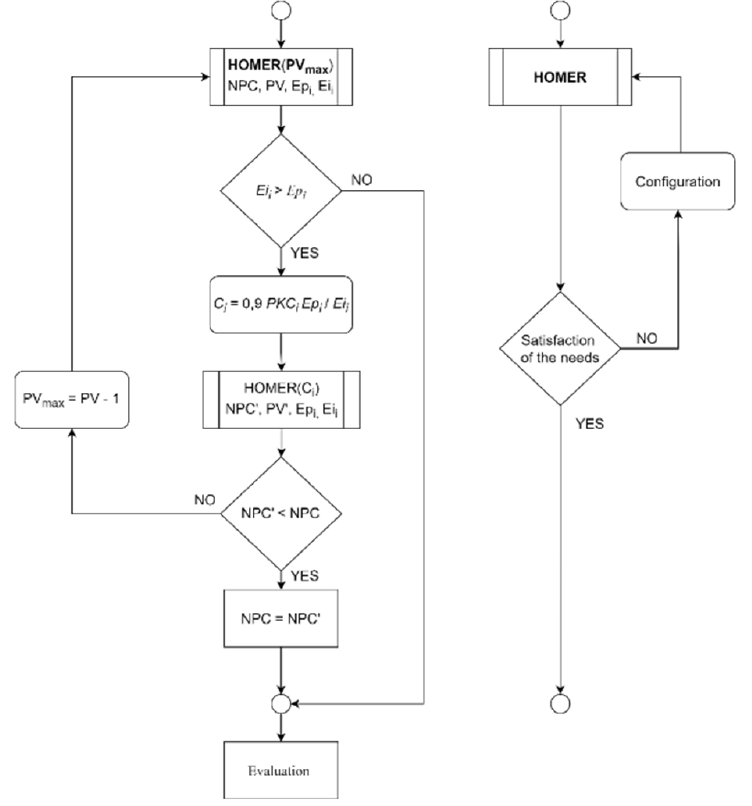
Figure 8. Flow diagram of the simulation correction algorithm. 4. Simulation and optimization of the selected microgrid solution scenario : A simple optimiza- tion procedure was